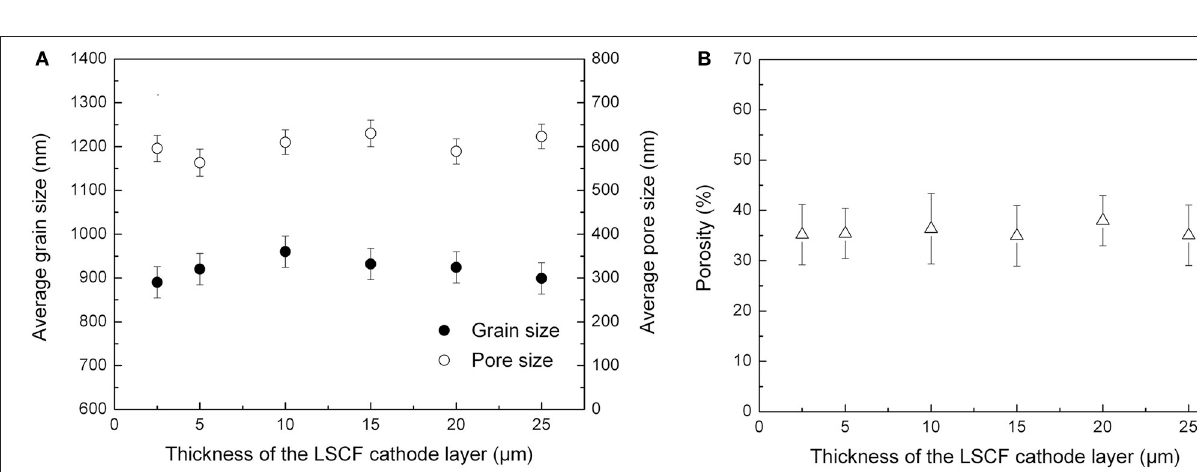
FIGURE 9 | (A) Average grain size and pore diameter in the cathode layer, and (B) Porosity of the cathode.